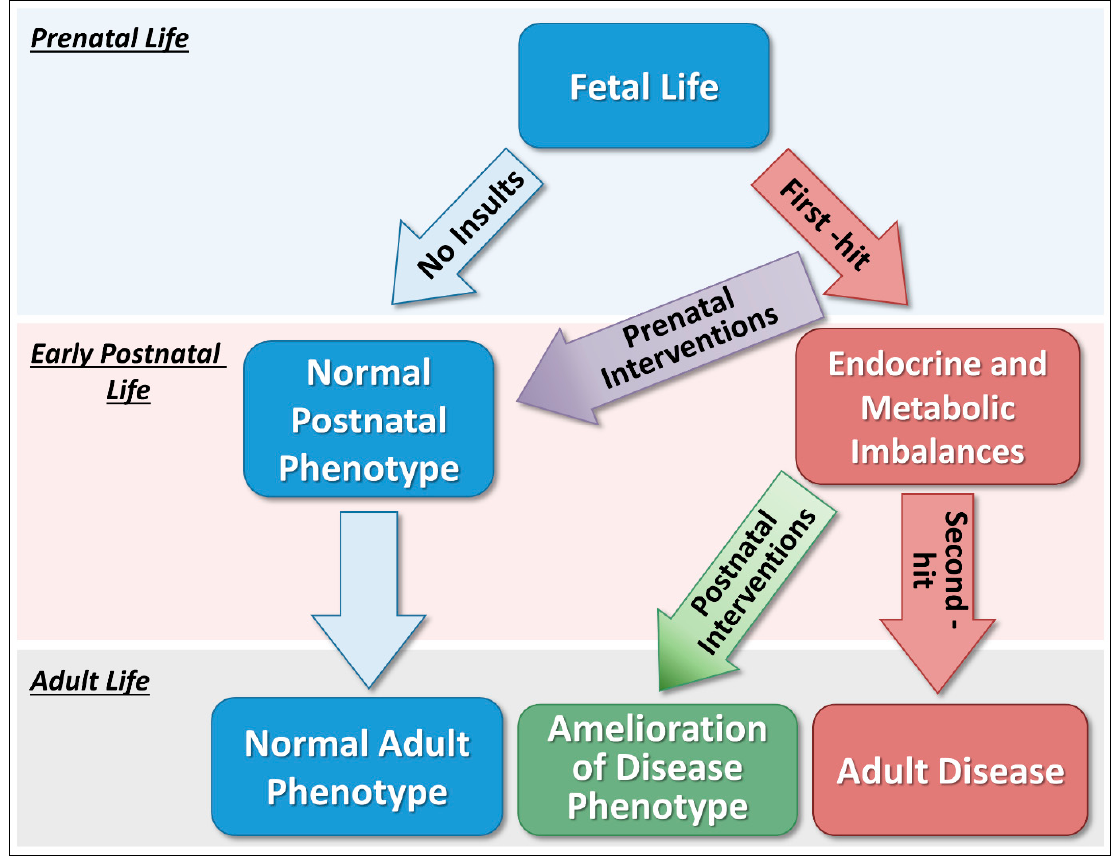
Figure 1. Two-hit hypothesis for adult onset of diseases. Insults occurring during the prenatal life constitute a “first-hit” that can lead to reorganization of several organ systems. Despite these modifications, this “first-hit” alone might be insufficient to alter the adult phenotype resulting in disease. However, endocrine and metabolic imbalances occurring later in life may act as a “second-hit”, which through activational effects might unmask or amplify the modifications programmed prenatally, thus culminating in the development of adult disease. On the other hand, prenatal interventions that can negate the effects of “first-hit” insults may successfully prevent the manifestation of some disease traits. Postnatal interventions that avert the effects of “second-hit” stressors may ameliorate the disease phenotype by preventing the manifestation of some disease traits.